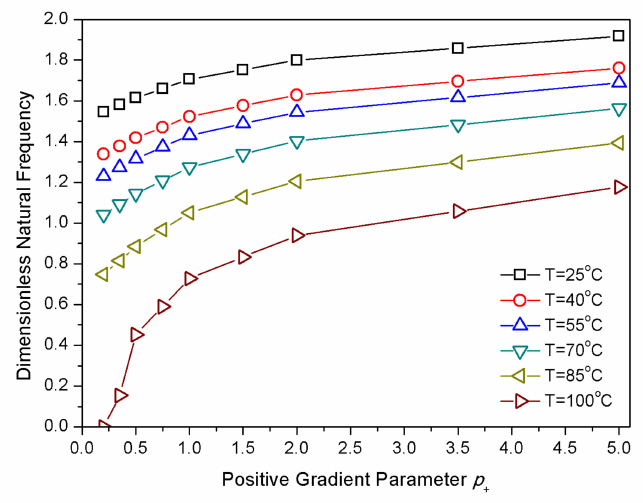
Figure 5. Dimensionless natural frequencies vs. the positive gradient parameter ( p + ) subjected to di ff erent temperatures.